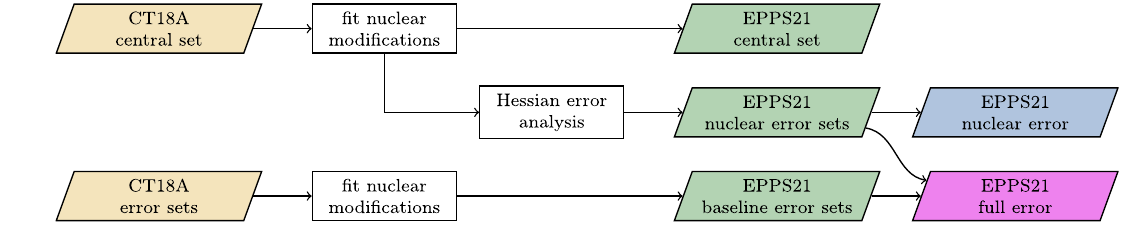
E615 data [87] is for the ratios,